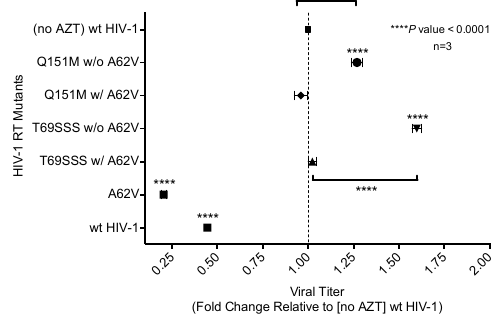
Figure 4. Analysis of relative drug susceptibility of multi-drug-resistant HIV-1 mutants in the presence or absence of A62V. Normalized virus stocks were used in the single-cycle assay to determine the relative drug susceptibility of the multi-dideoxynucleoside resistant (MDR) HIV-1 Q151M mutant complex (i.e., A62V, V75I, F77L, F116Y, and Q151M), and the T69SSS insertion complex (i.e., M41L, A62V, T69SSS, K70R, and T215Y) in the presence or absence of A62V under AZT-selective pressure. Virus titers were determined by flow cytometry. All drug susceptibility values were set relative to no-AZT wt HIV-1 for each experimental replicate. The standard error of the mean (SEM) is indicated by the error bars. **** p -value <